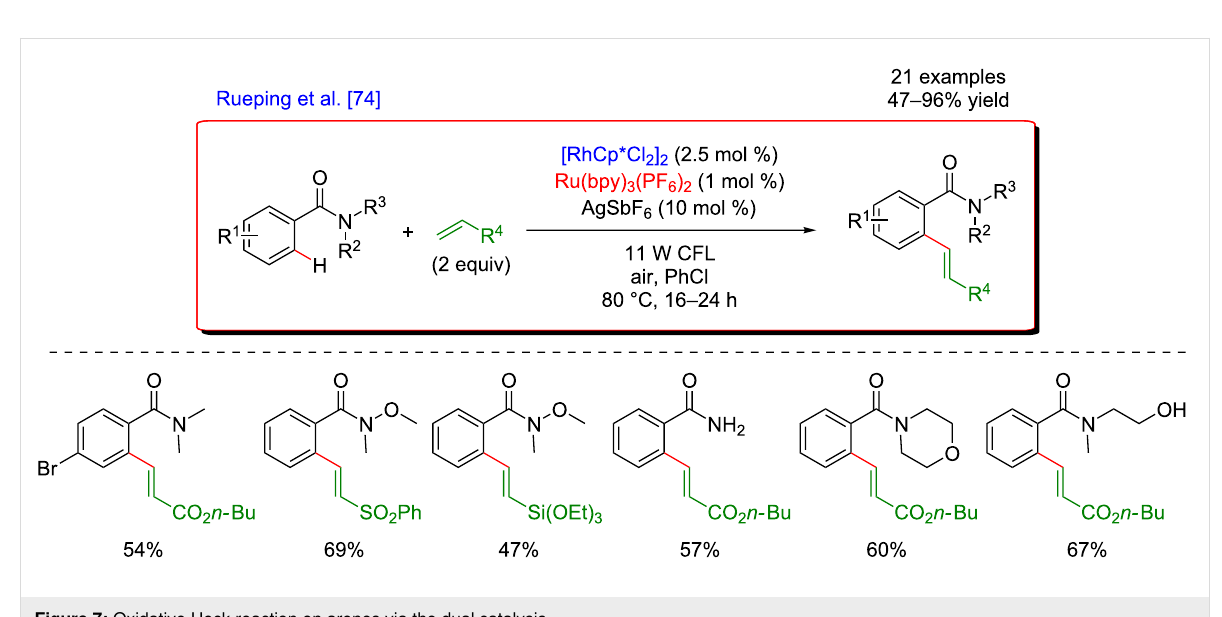
allow in situ reoxidation of the metal catalyst. In 2015, a proce- dure combining ruthenium C–H activation of phenols deriva- tives bearing a pyridine moiety as DG and photoredox catalysis was disclosed (Figure 9) [75]. This ortho -olefination was per- formed under air atmosphere and required harsh reaction condi- tions with temperatures of up to 120 °C. The substituents on both substrates had a minor impact on the reaction outcome and the coupling products were isolated in comparable yields. The